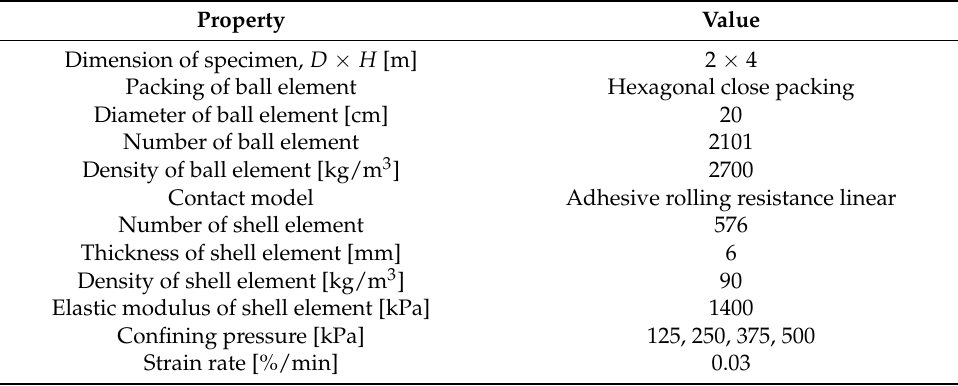
Table 3. Details of large-scale triaxial test model for calibration of contact parameters.